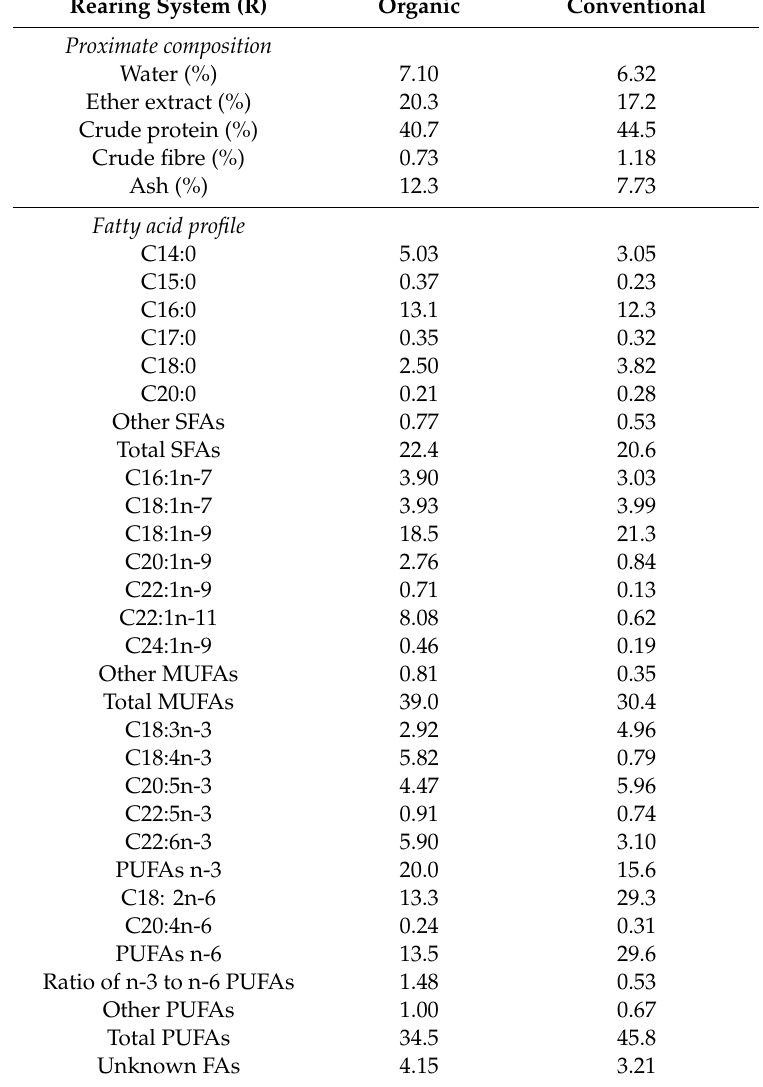
Table 1. Proximate composition (% as-fed) and fatty acid profile (% total fatty acids methyl esters) of the